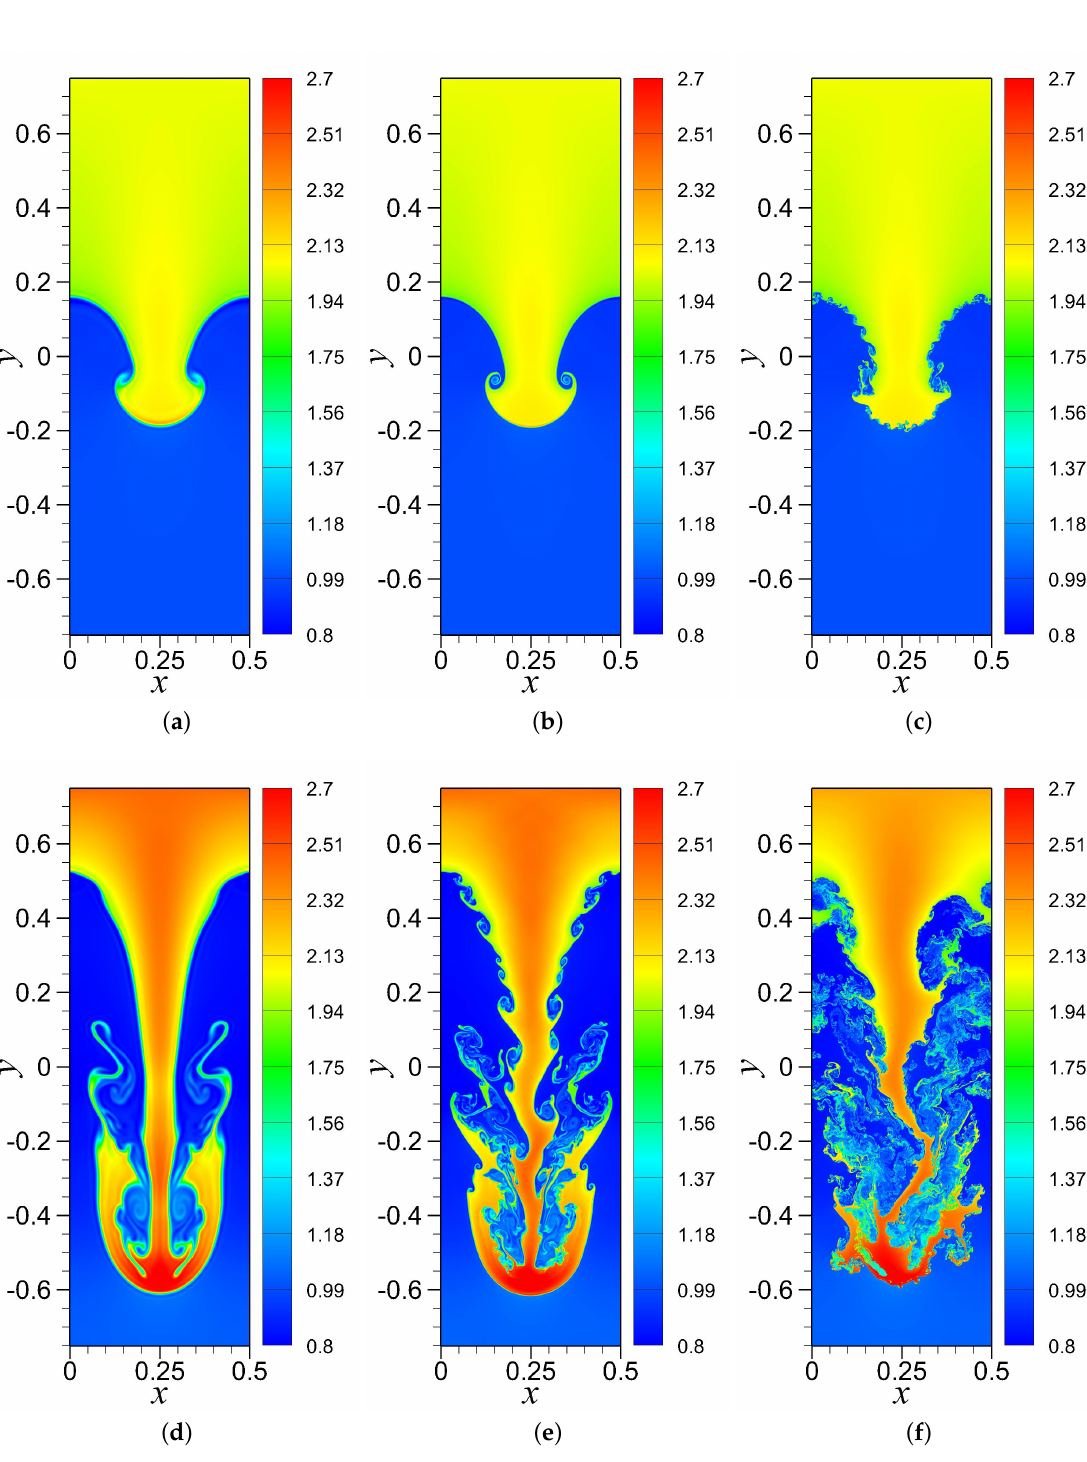
Figure 17. Time evolution of density field for the RTI problem with single-mode perturbation for different coarse grid resolutions using CS+RF scheme ( σ = 1.0): ( a ) CS+RF scheme ( σ = 1.0) with 256 × 768 resolution at t = 2.7; ( b ) CS+RF scheme ( σ = 1.0) with 1024 × 3072 resolution at t = 2.7; and ( c ) CS+RF scheme ( σ = 1.0) with 4096 × 12288 resolution at t = 2.7; ( d ) CS+RF scheme ( σ = 1.0) with 256 × 768 resolution at t = 4.5; ( e ) CS+RF scheme ( σ = 1.0) with 1024 × 3072 resolution at t = 4.5; and ( f ) CS+RF scheme ( σ = 1.0) with 4096 × 12288 resolution at t = 4.5. The gravity is directed in a vertically downward